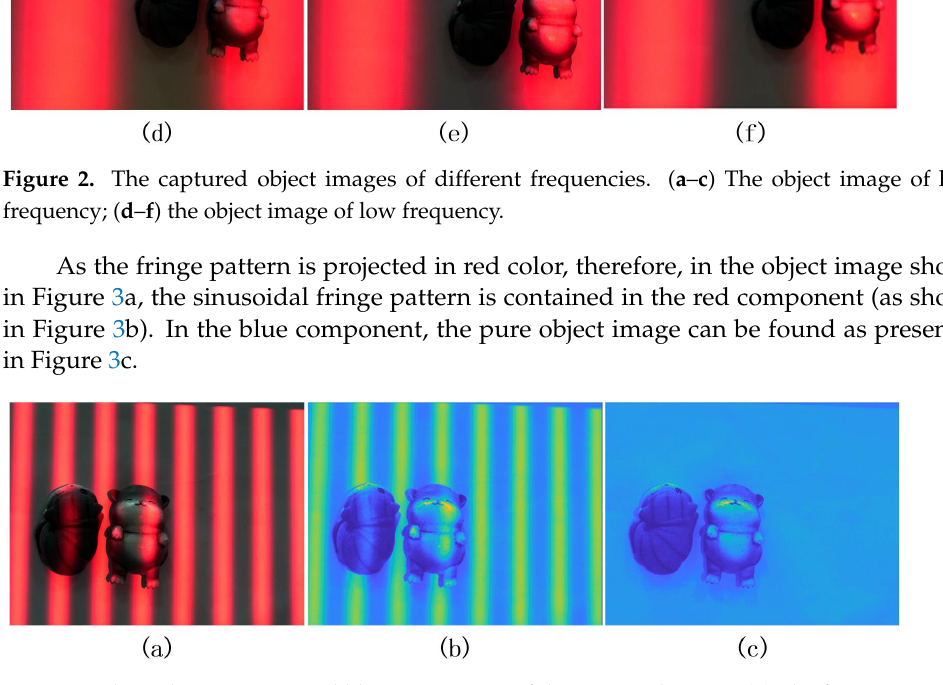
Figure 3. The red component and blue component of the captured image. ( a ) The fringe pattern of the object; ( b ) the red component image of ( a ); ( c ) the blue component image of ( a ).